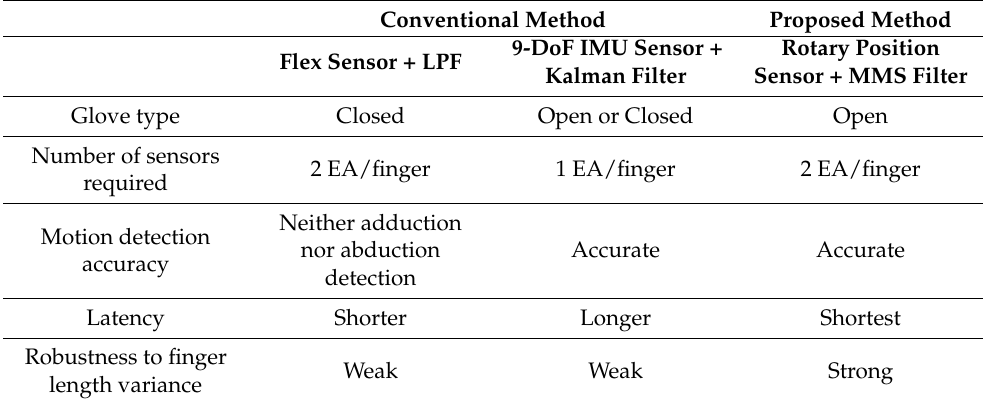
Table 1. Features of the conventional method and the proposed Haptic